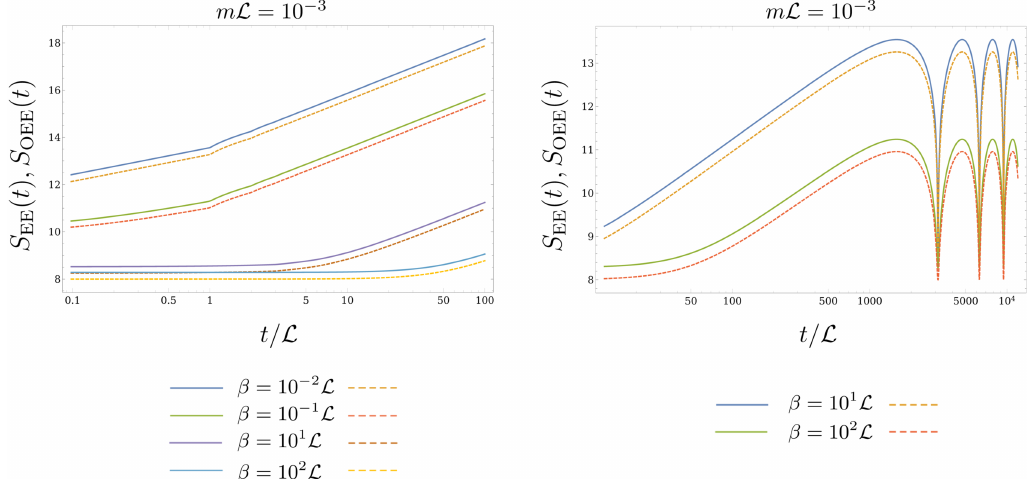
Figure 11 . Temperature effect for adjacent configurations: the time dependence of S OEE (dashed) and S (solid) are presented for different temperatures. We take N =1501 , N EE =1+1 N A L 2 ( R 2 )